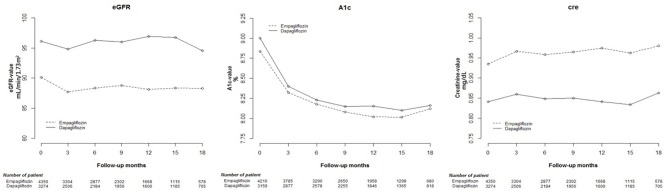
Change in estimated glomerular filtration rate (eGFR), and glycated hemoglobin (HbA1c), and creatinine (Cre) levels in empagliflozin and dapagliflozin users.